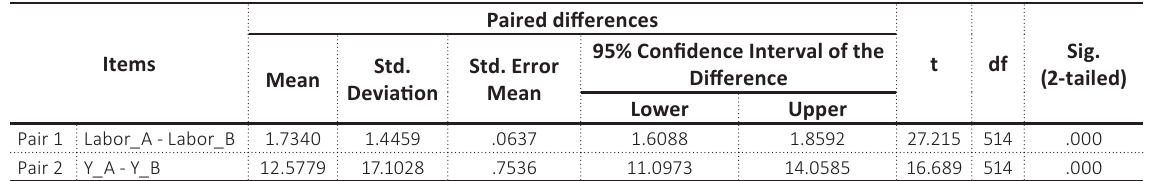
Table 4. Paired sample test Paired differences Items Std. (2-tailed)Mean